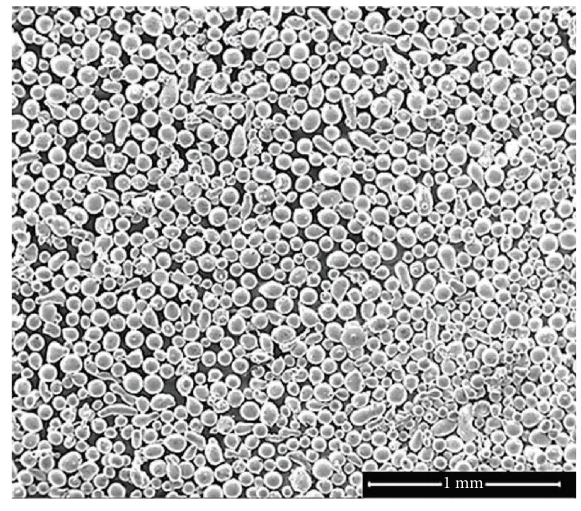
Figure 1: SEM for powder SS316L.